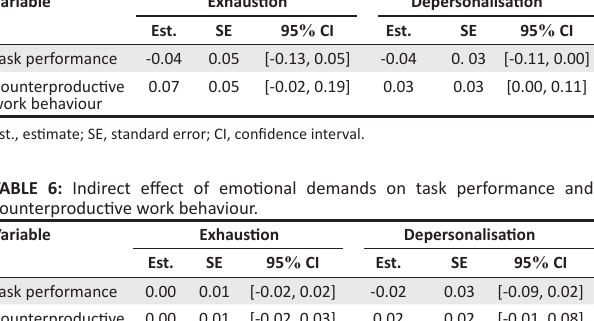
TABLE 5: Indirect effect of work pressure on task performance and counterproductive work behaviour. Variable